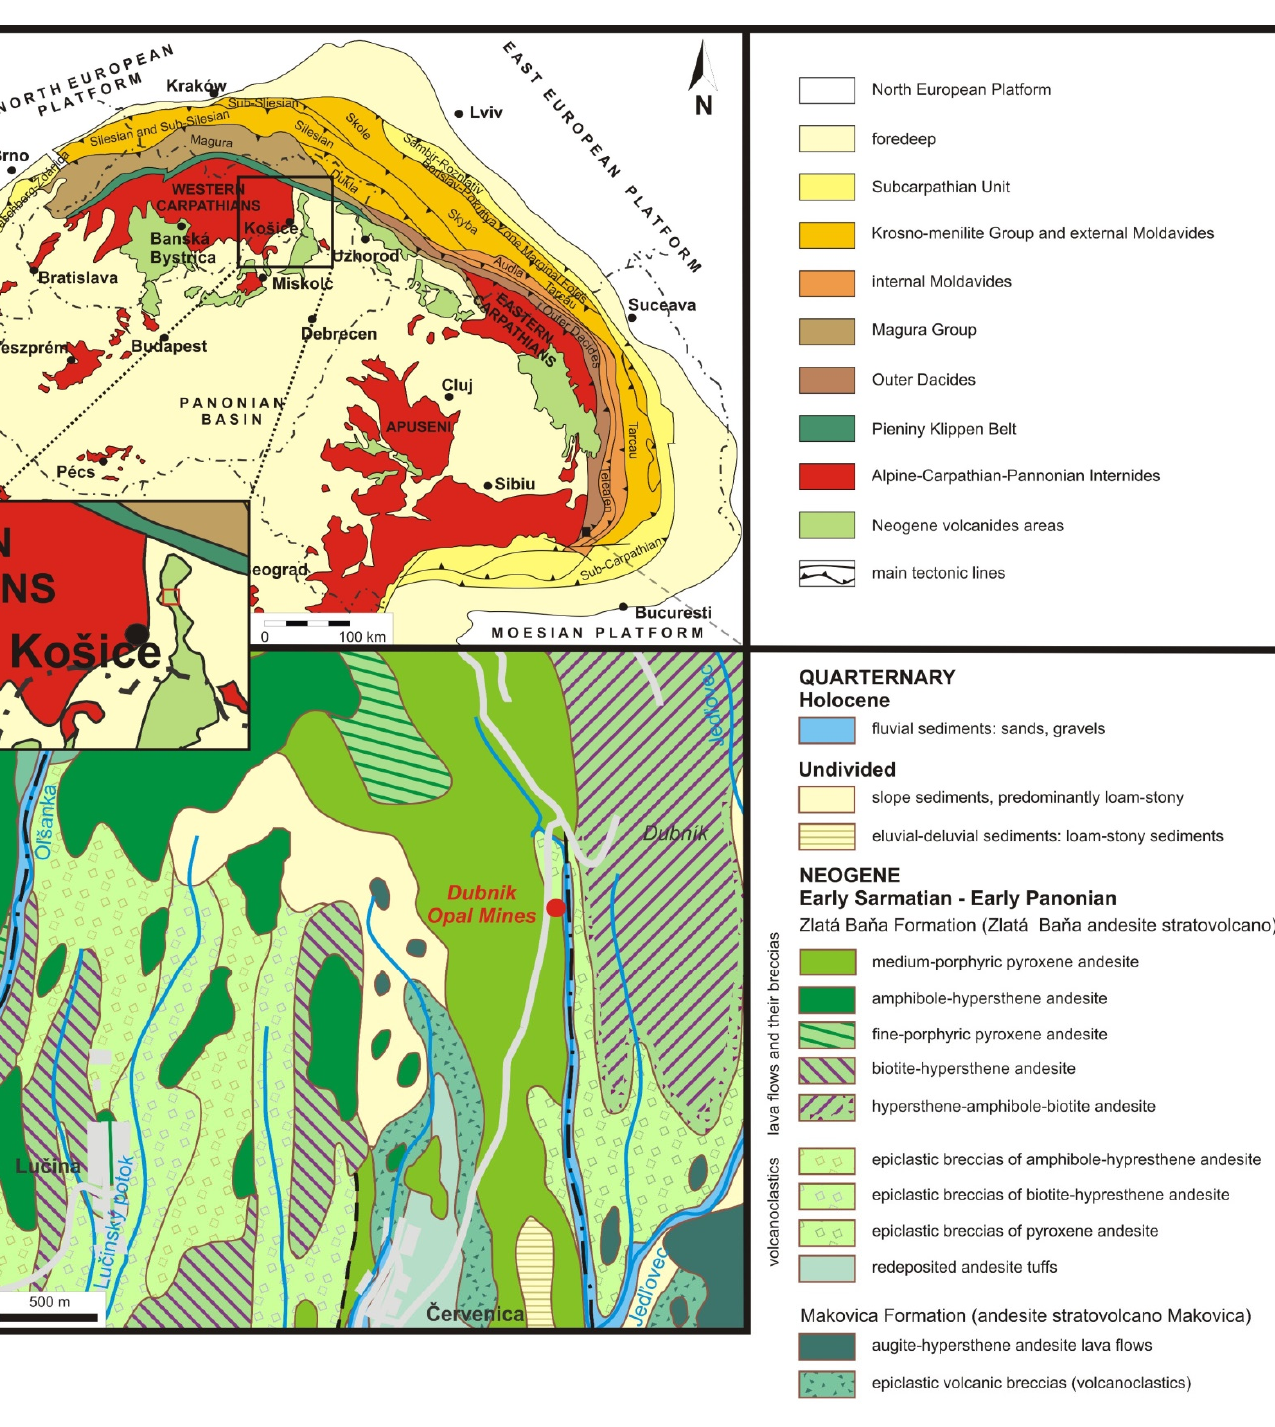
Figure 2. Geological map of studied area (after [24,25], modified).